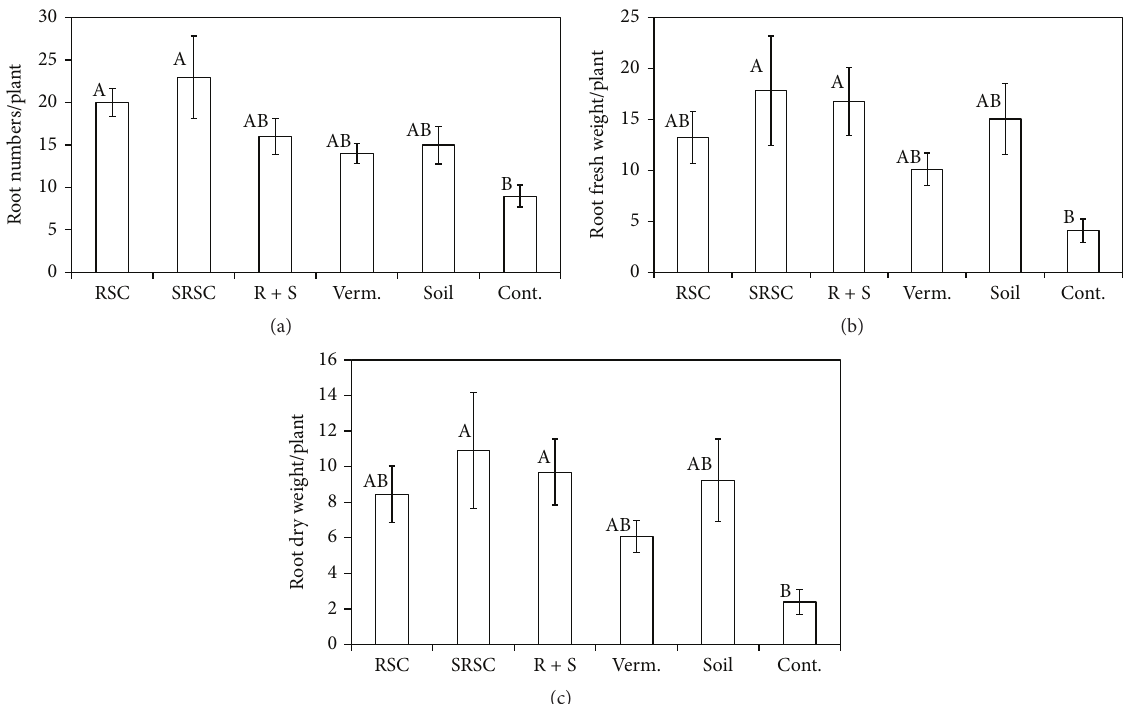
Figure 2: Number (a), dry (b) and fresh weight (c) of “M.9” roots per plant which appeared after 6-month treatment with rice seed coat (RSC), smoked rice seed coat (SRSC), combined 50% RSC and 50% SRSC (R + S), vermiculite (Verm.), soil (Soil), and no soil (Cont.). Values represent the means ± SE of 4 or 7 plants, and those with different letters differed significantly at 𝑃 < 0.01 by one-way anova followed by Dunnett’s multiple comparison